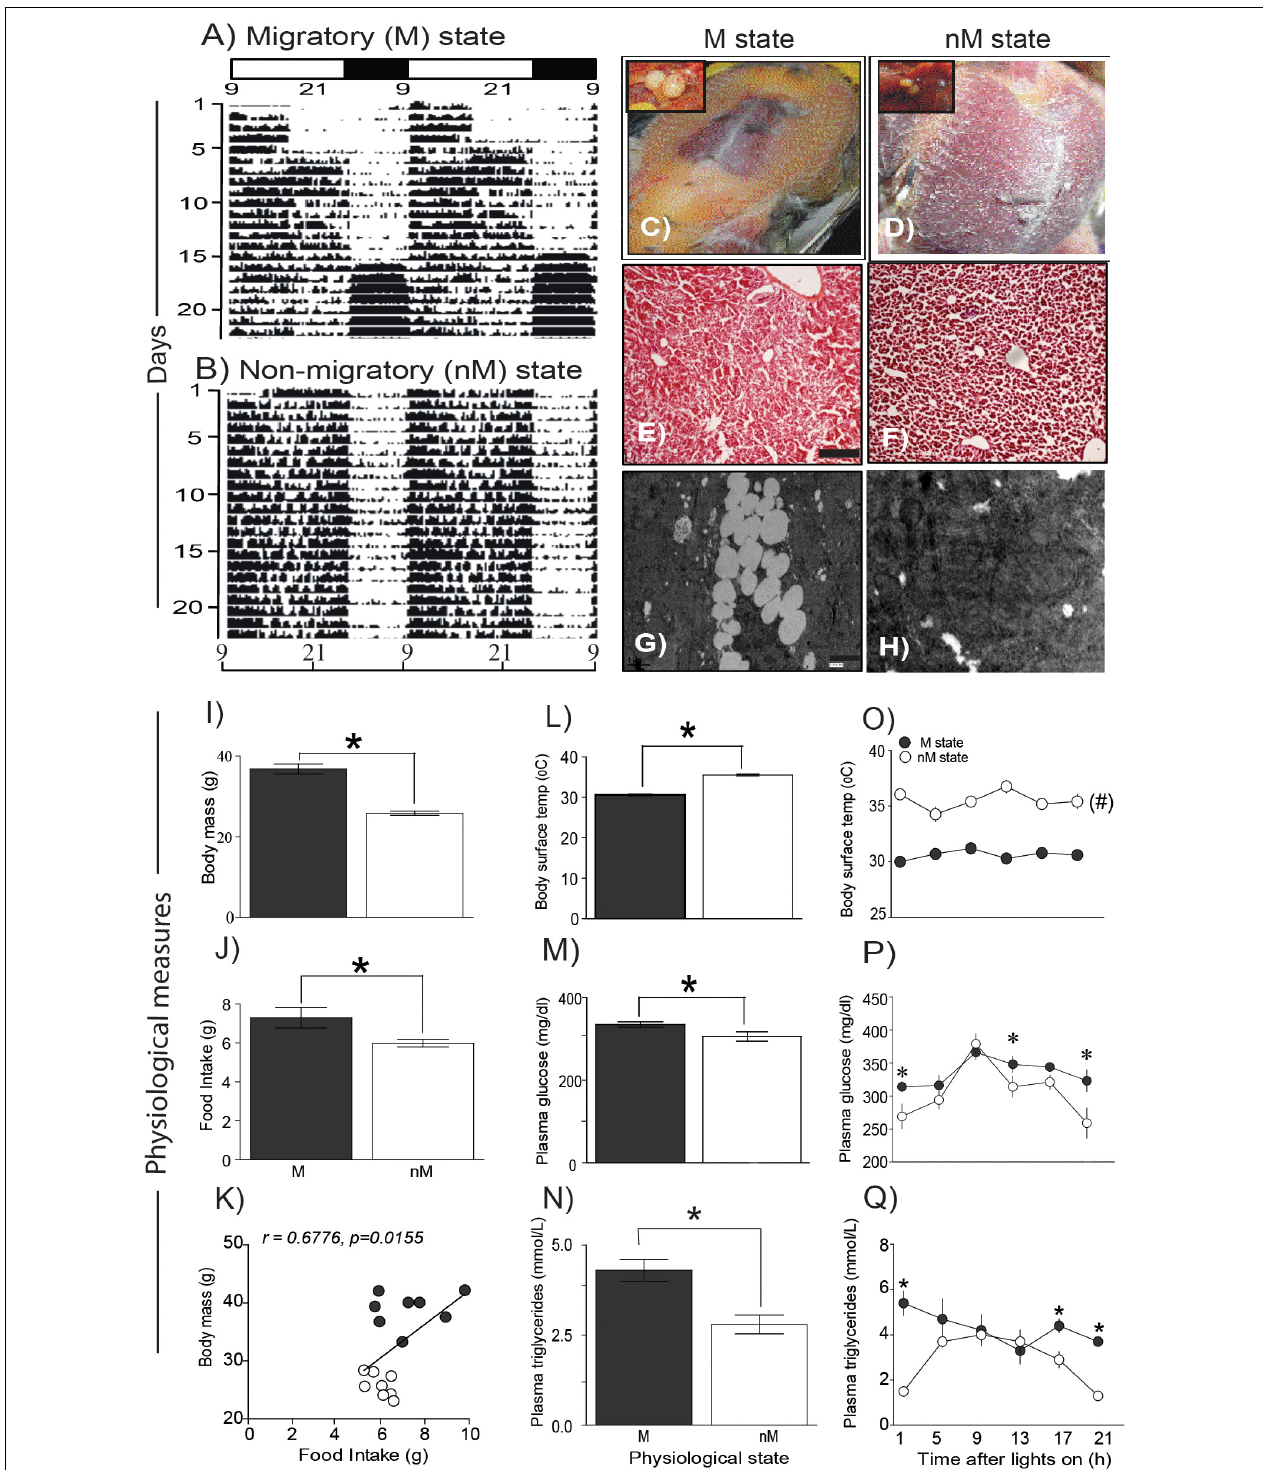
FIGURE 1 | Phenotypic and physiological measures in migratory and non-migratory seasonal states. (A , B) representative actograms plotted on clock hours (L on 09:00 am; L off 01:00 am) under photostimulated migratory (M) and photorefractory non-migratory (nM) states. (C , D) show fat deposition in M and nM states, respectively, along with relative testis size in the left top inset. Similarly, histological details in H-E stained simple microscopy, scale bar 200 µ m (E,F) and